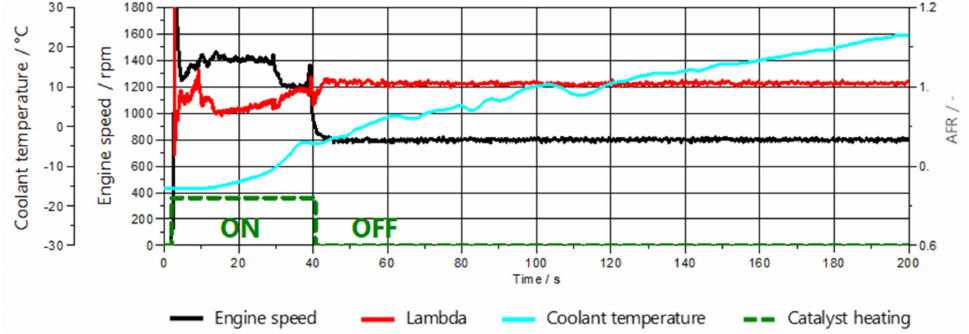
Figure 3. Engine operating parameters at a − 15 ◦ C cold start.